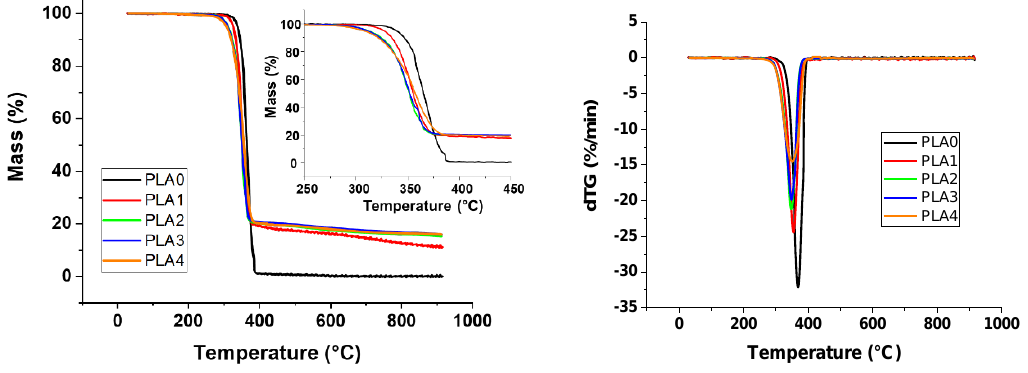
Figure 8. TG and DTG for PLA/APP/S9 composites.